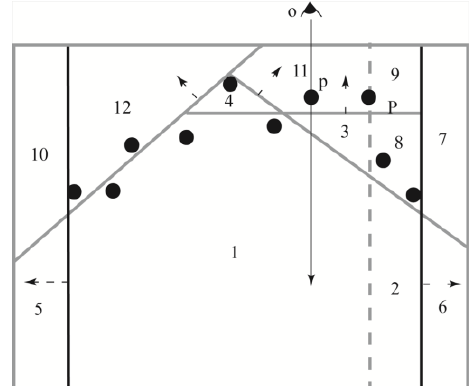
Figure 4. Visibility analysis of cells: the two dark solid lines are the facade planes derived from the building boundary; the dash line is the facade plane derived from step edge; the short dash lines with arrows are the normal directions of corresponding building